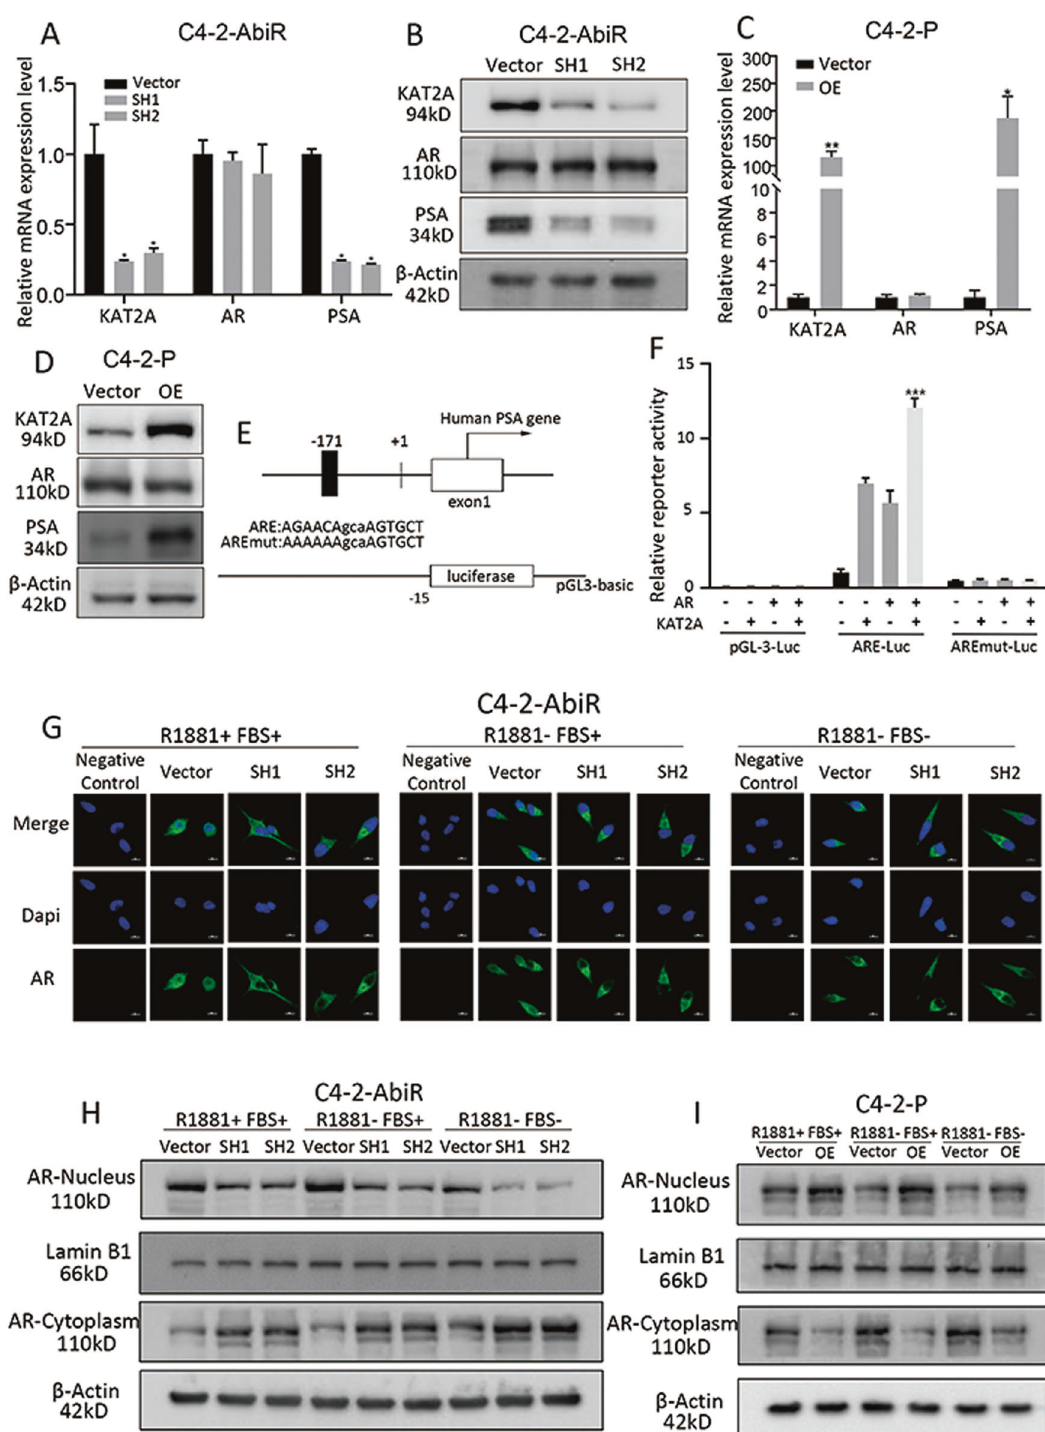
Fig. 4 KAT2A promotes AR activity by facilitating its nuclear translocation. A Relative mRNA expression levels of KAT2A, AR and PSA in C4- 2-AbiR stably transfected with sh-KAT2A or vectors were detected by qRT-PCR. B The protein levels of KAT2A, AR and PSA in C4-2-AbiR stably transfected with sh-KAT2A or vectors were detected by western blotting. c Relative mRNA expression levels of KAT2A, AR and PSA in C4-2-P stably transfected with OE-KAT2A or vectors were detected by qRT-PCR. D The protein levels of KAT2A, AR and PSA in C4-2-P stably transfected with OE-KAT2A or vectors were detected by western blotting. E Pattern of pGL3-basic containing promoter of PSA and mutant. F Dual-luciferase assays performed using the control pGL3, ARE, and AREmut constructs in the presence or absence of exogenous KAT2A and AR. G Location of AR in C4-2-AbiR stably transfected with sh-KAT2A or vectors was detected by IF. H Aggregate of AR in cytoplasm or nucleus in C4-2-AbiR stably transfected with sh-KAT2A or vectors were extracted and detected. I Aggregate of AR in cytoplasm or nucleus in C4-2-P stably transfected with oe-KAT2A or vectors were extracted and detected. * p < 0.05, ** p < 0.01, *** p < 0.001.